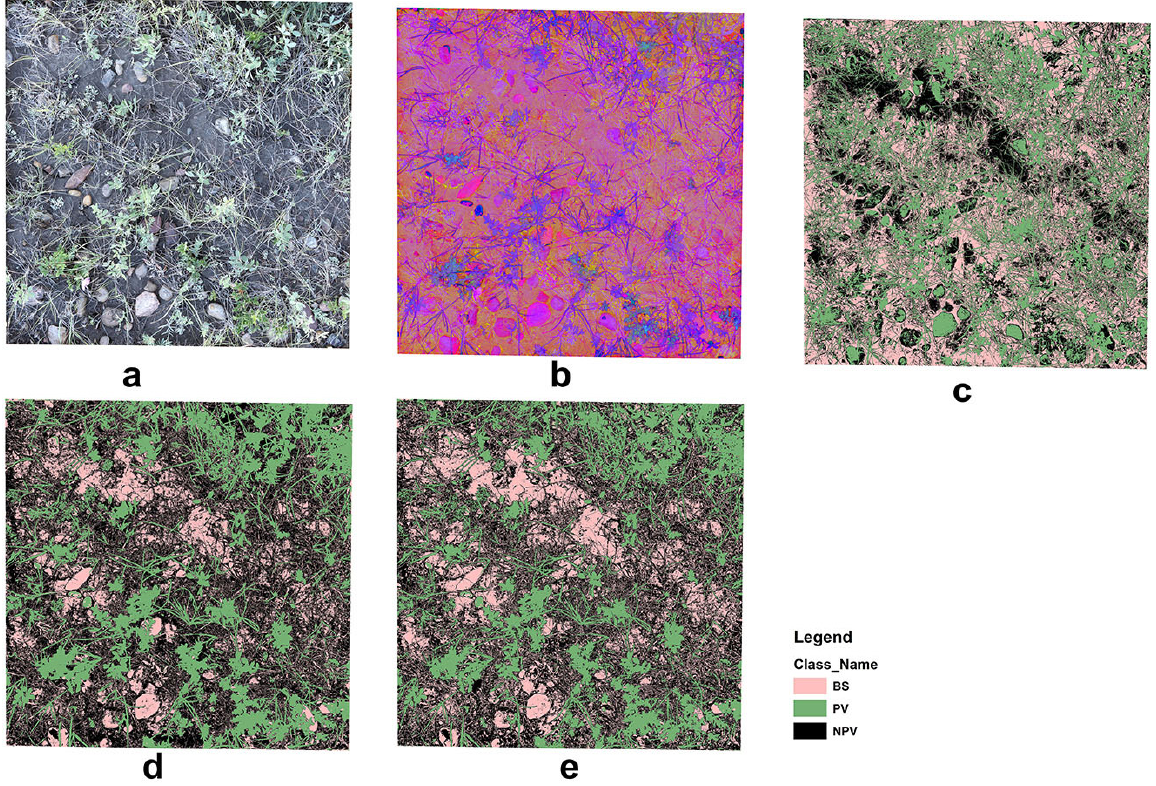
Figure 9. Example of image analyses: ( a ) original RGB image, ( b ) HIS image, ( c ) unsupervised image classification, ( d ) supervised image classification, and ( e ) OBIA.